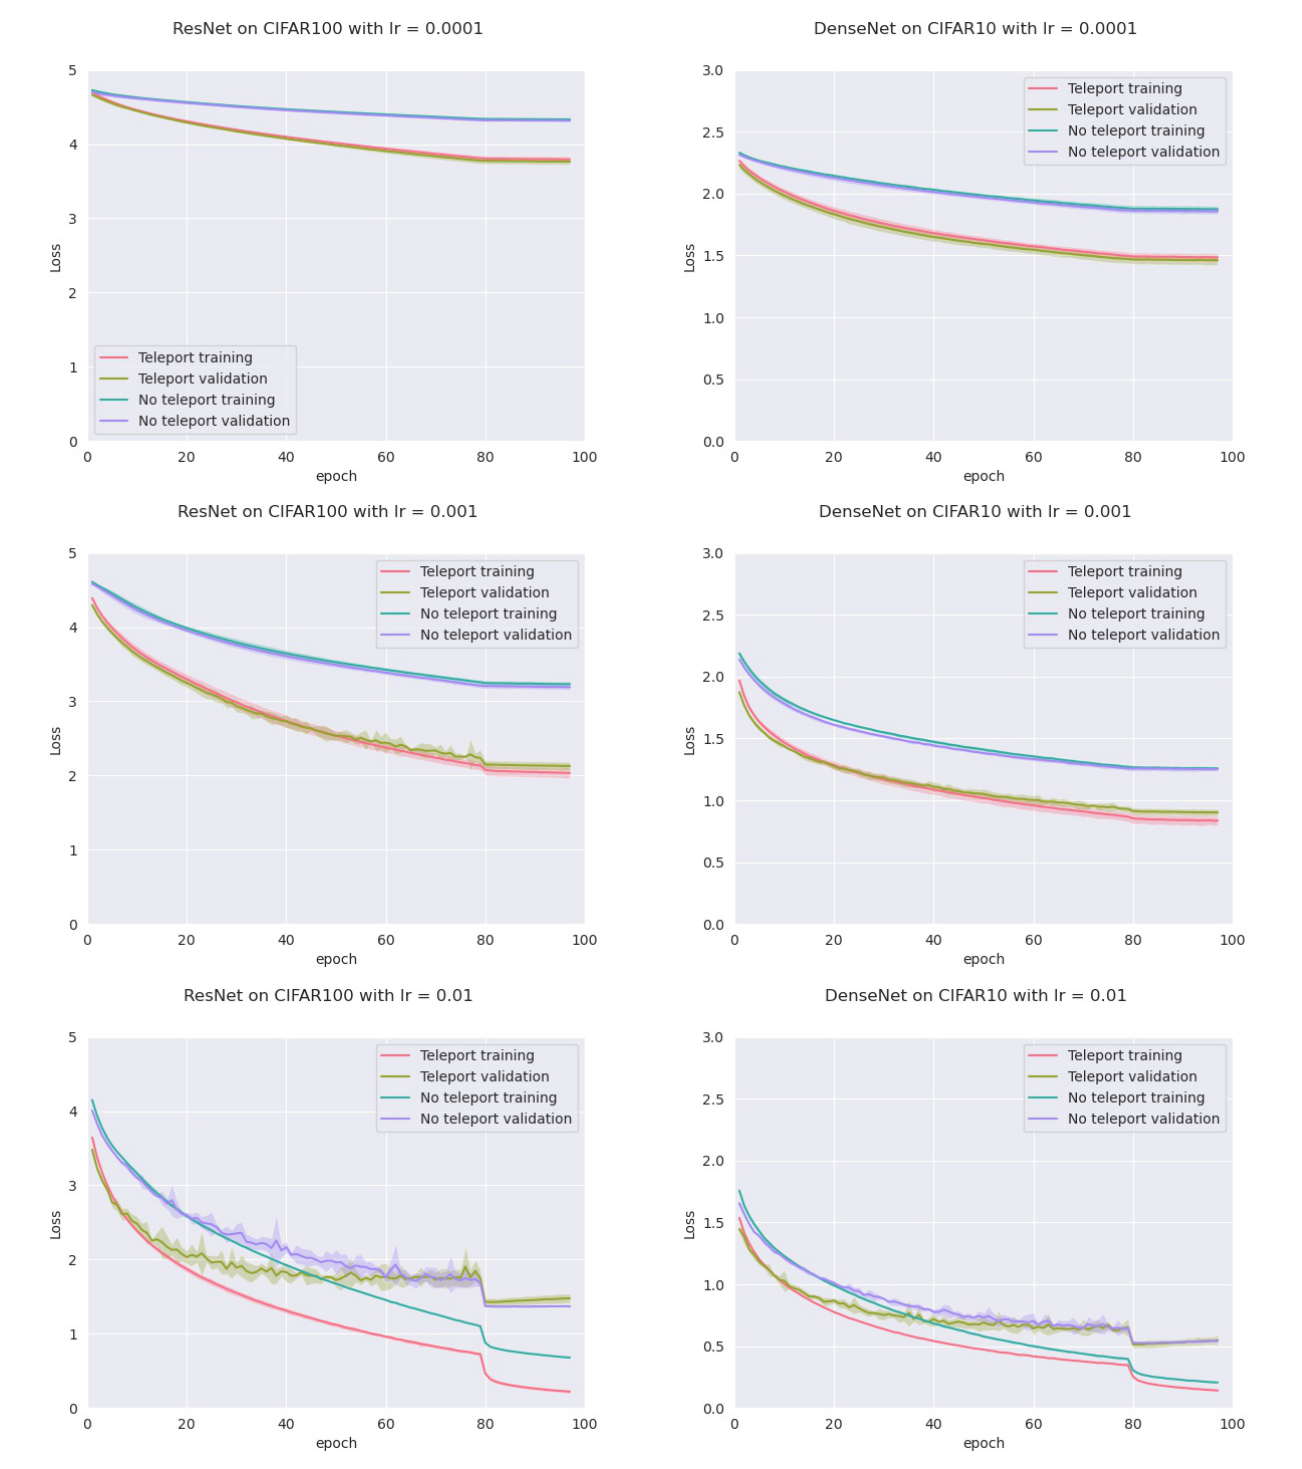
Figure 6. Average loss of ResNet on CIFAR100 ( left ) and DenseNet on CIFAR10 ( right ) over 5 experi- ments, with and without teleportation, at the beginning of the training with CoB of 0.9. Learning rate increases from top to bottom rows. We also show a shadow around the average curves at two times the standard deviation over the five